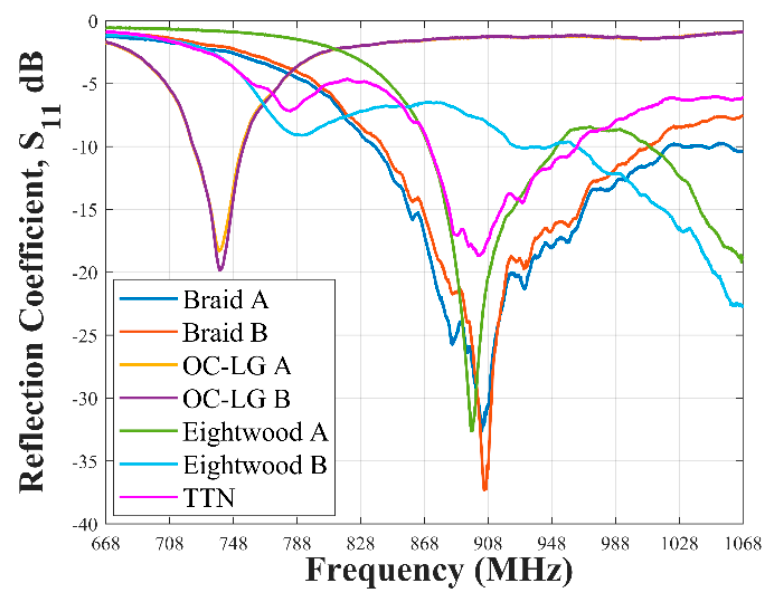
Figure 14. Measured S11 of braided and benchmarking antennas.